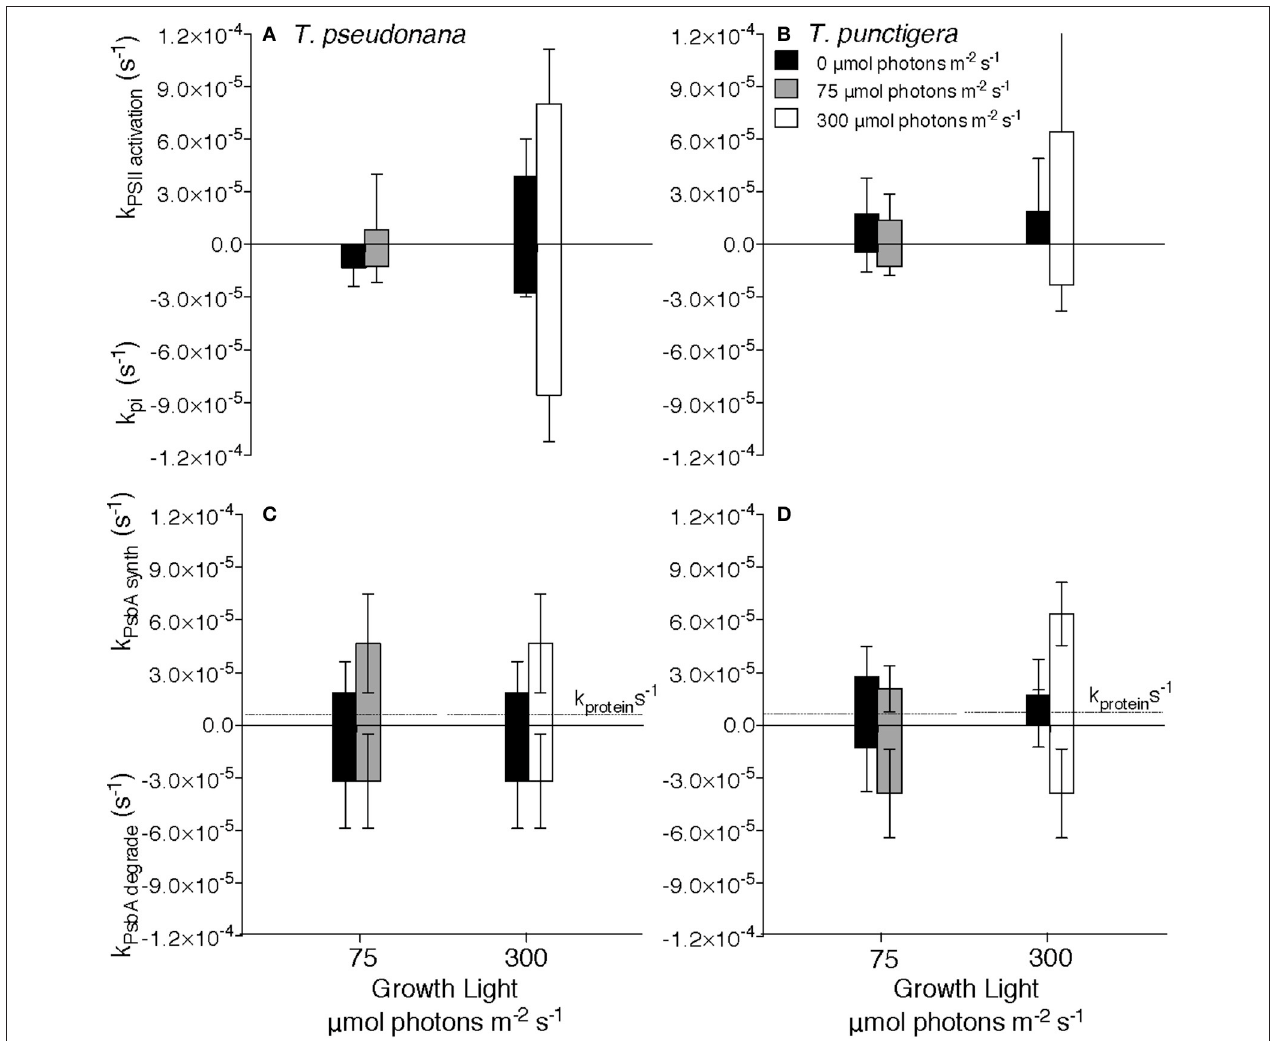
FIGURE 2 | Rate constants for Photosystem II cycling. Rate constants for Photosystem II inactivation (kpi) for T. pseudonana (A) or T. punctigera (B) measured under darkness (closed bars), 75 (shaded bars) or 300 (open bars) µ mol photons m − 2 s − 1 . Rate constants for synthesis (k PsbA synth ) or removal (k PsbA degrade ) of PsbA protein for T. pseudonana (C) or T. punctigera (D) . Data pooled from determinations under 4:20, 8:16 and 16:8 L:D cycles, 2–4 separate determinations per diel cycle upon two independent cultures for each combination of growth light, diel cycle and species. n = 4–36, ± SD Horizontal dotted lines at ∼ 0.5 × 10 − 5 s − 1